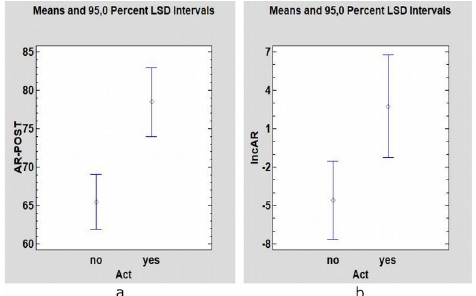
Figure 4. Effect of self-feedback activity on the post